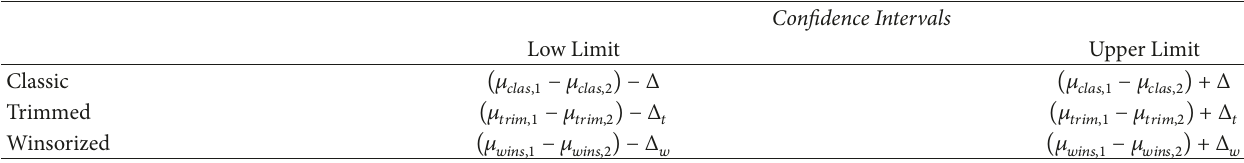
Table 6: Relations to calculate the confidence intervals for the hypothesis